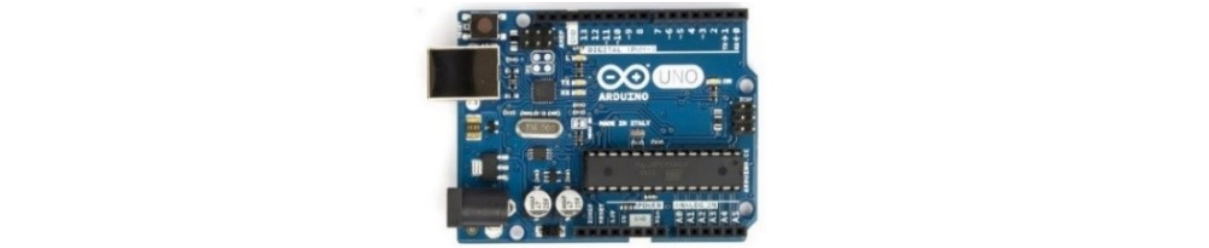
Figure 3. Arduino UNO microcontroller.